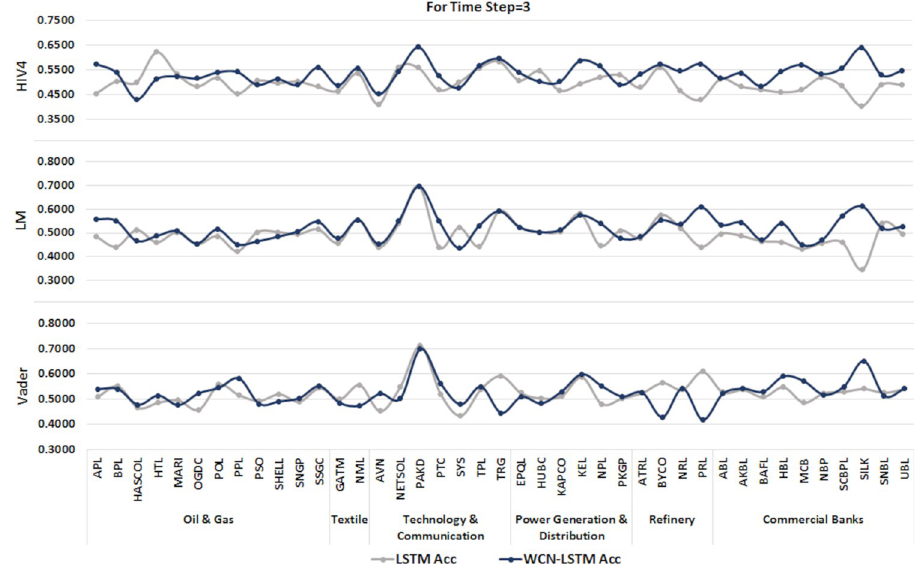
Fig 4. Accuracy of prediction models by incorporating information from the last 3 days using the test set.